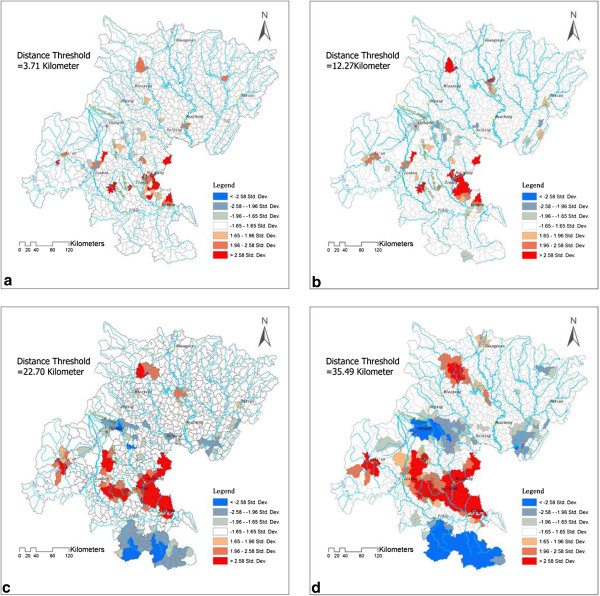
HotspotsDetected byGetis'sGi*. It is the hotspots map of CHD prevalence detected by Getis'sGi* statistics at different distance thresholds. (a) distance threshold = 3.71 km, (b) distance threshold = 12.27 km, (c) distance threshold = 22.70 km, (d) distance threshold = 35.49 km.